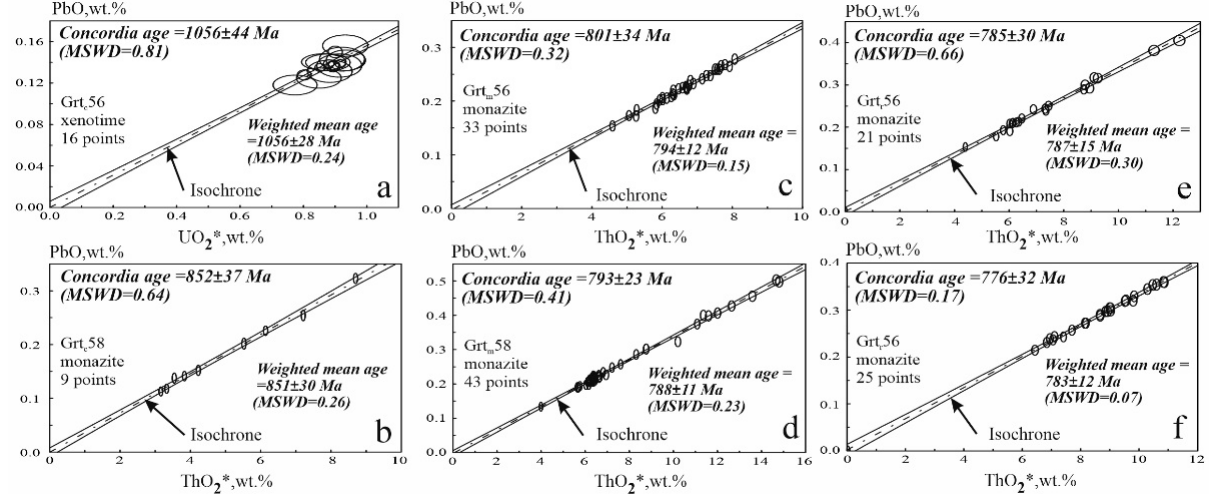
Figure 28. Concordia ages for the population of data on PbO/UO 2 * ( a ) and PbO/ThO 2 * ( b – f ) (ThO 2 plus the equivalent of UO 2 ) and Th-U-Pb weighted mean ages for single data points in xenotime ( a ) and monazite ( b – f ). Dashed lines are regressed isochrones with two symmetrical hyperboles, which fixed errors. Garnet zone designation is the same as for Figure 8.